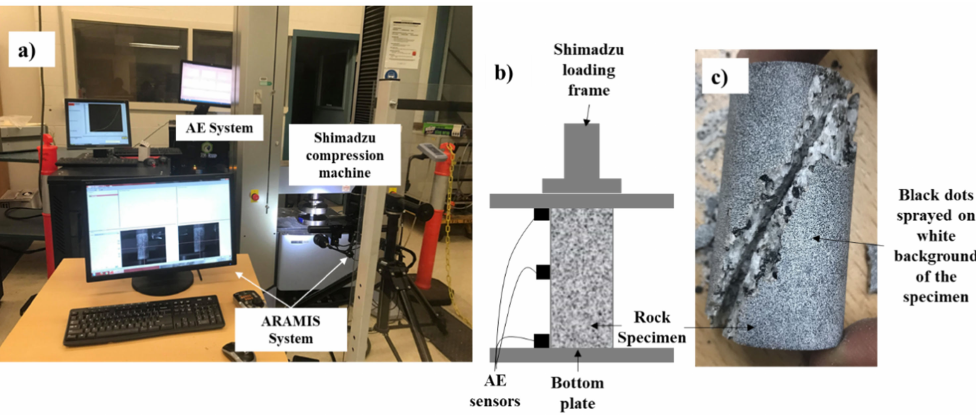
Figure 4. Uniaxial compressive strength (UCS) testing set-up (Shimadzu compression machine) with acoustic emission (AE) system and ARAMIS system ( a ), the sample instrumentation ( b ), and a tested rock specimen with paint spayed on the 3-D surface to detect the deformation by tracking co-ordinates ( c